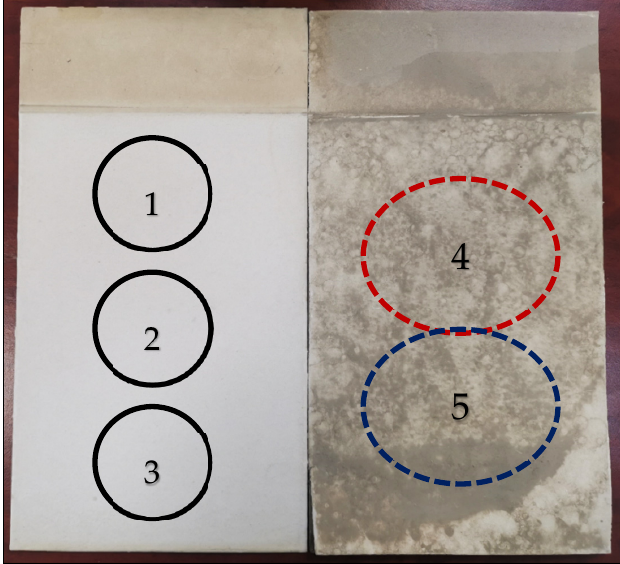
Figure 3. Panels showing three areas (1–3), where reflectance and emittance were analyzed and two dashed areas (4, 5), where color analyses were carried out.